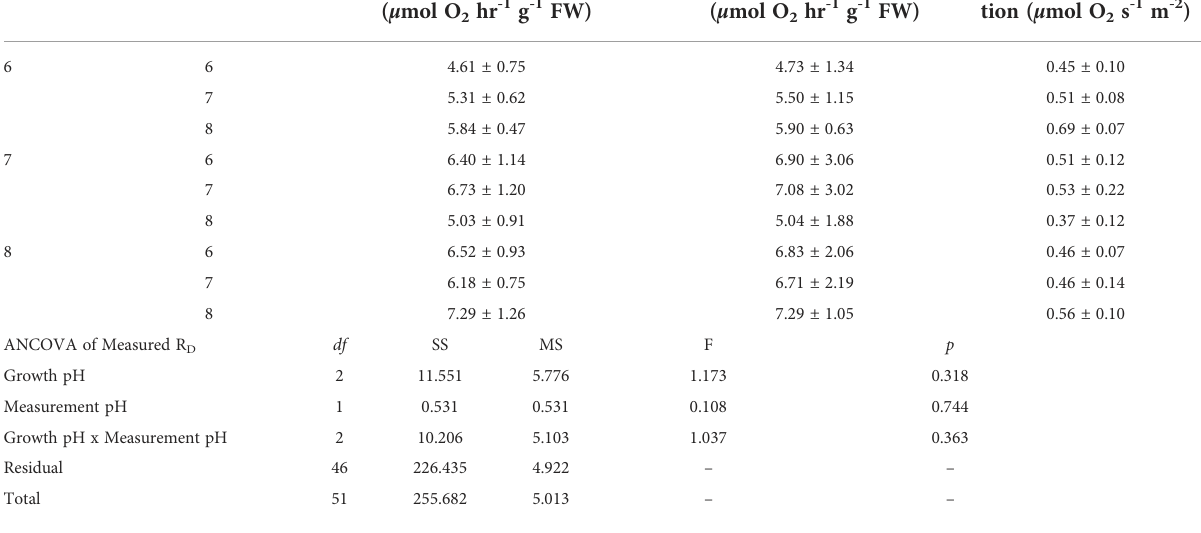
TABLE 4 Dark respiration (R D ) rates measured with O 2 evolution method and estimated by non-linear model fi t to P vs E